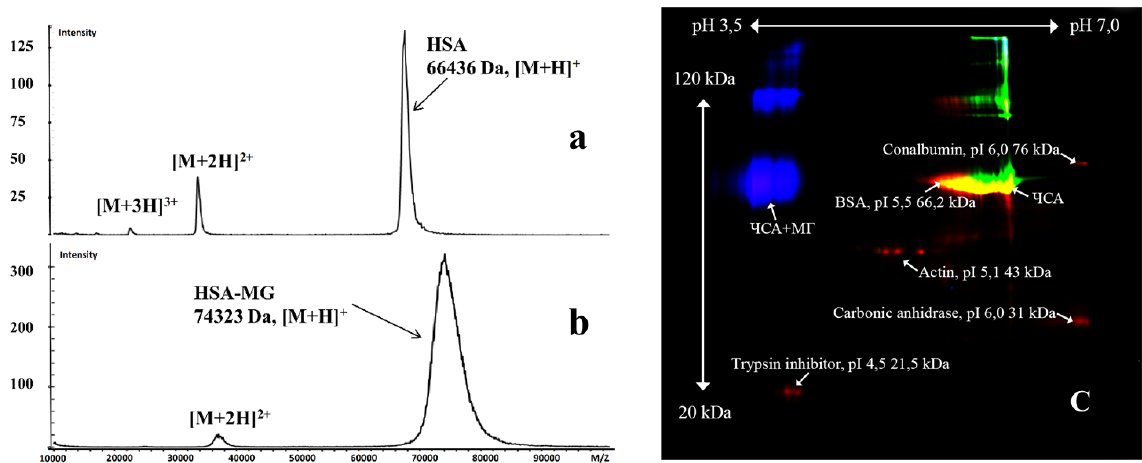
Figure 1. Molecular mass of HSA ( a ) and HSA-MG ( b ), analyzed by a MALDI–TOF mass spectrometer, as described in the Materials and Methods section. ( c ) DIGE analysis of HSA (green) and HSA-MG (blue) (pH range: 3.5 – 7).